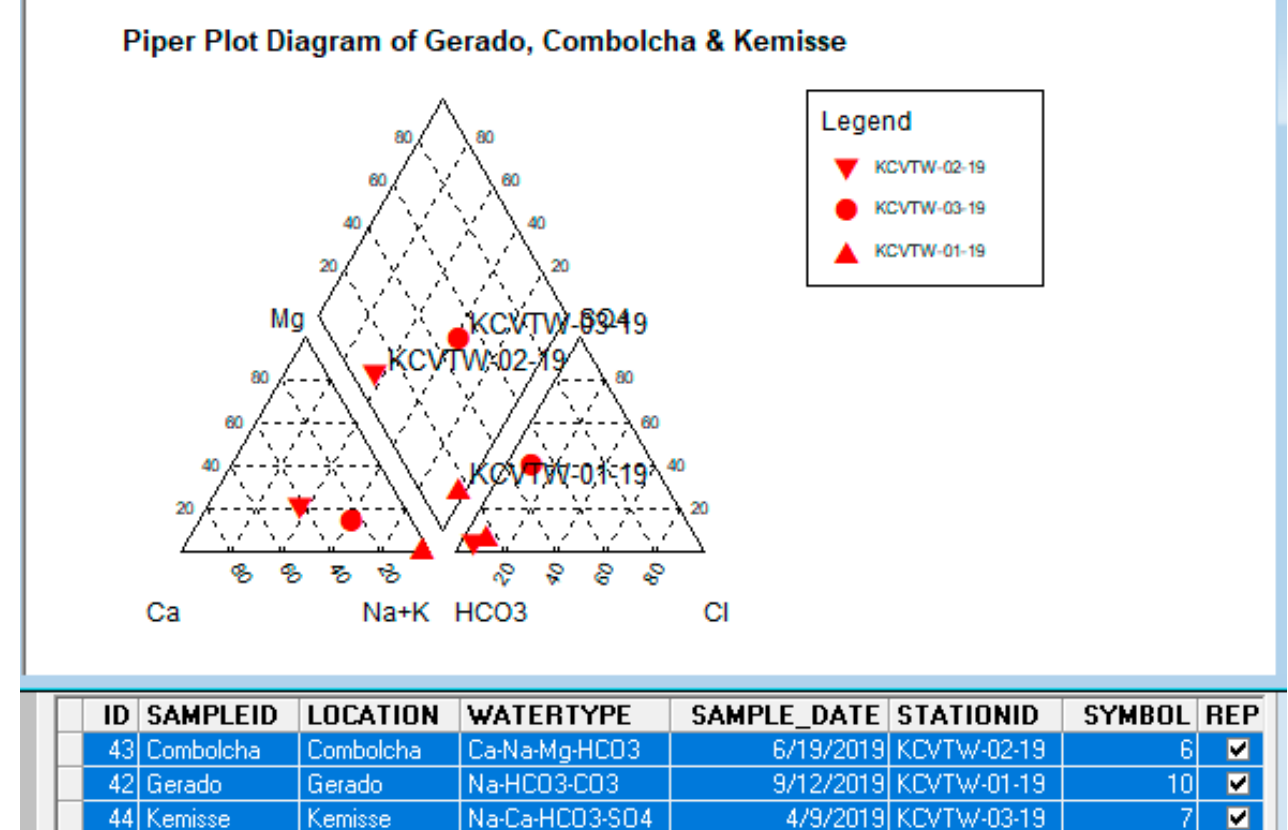
Figure 7. Piper plot diagram showing the water types of the existing three boreholes, produced using acquacheme software (data source: ECDSWC-WEDSWS).